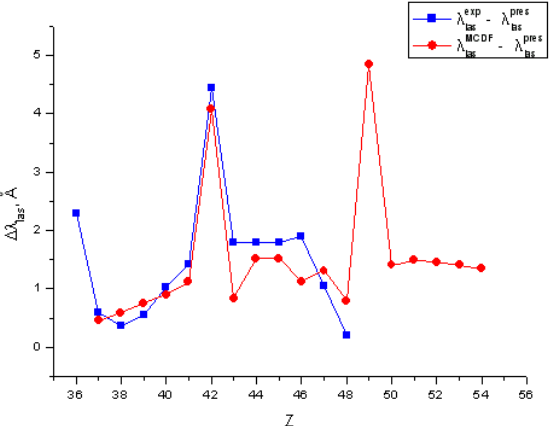
Figure 3. Difference between experimental, predicted from [4] and calculated here, λ las of SPP XRL transitions in Ni-like ions.